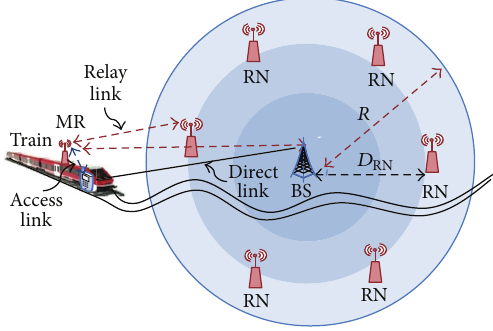
Figure 4: Vehicle travelling across a one cell